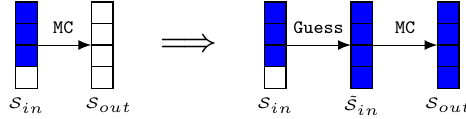
Figure 2: Introduce Guess operation before MC